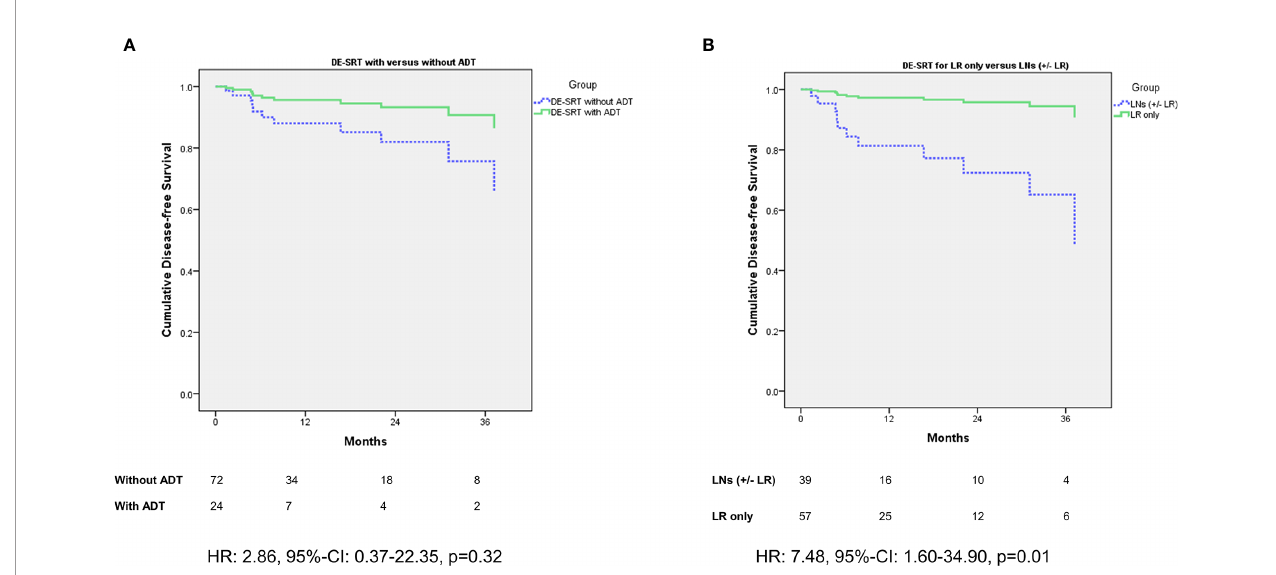
FIGURE 2 | Cox regression of disease-free survival (DFS) for dose-escalated salvage radiotherapy (DE-SRT) in the subgroups of patients with/without additive androgen deprivation therapy (ADT) (A) and Cox regression (adjusted for use of additive androgen deprivation therapy) with respect to the PET results (B) (LR, local recurrence; LN, pelvic lymph node(s); HR, hazard ratio; 95%-CI, 95%-con fi dence